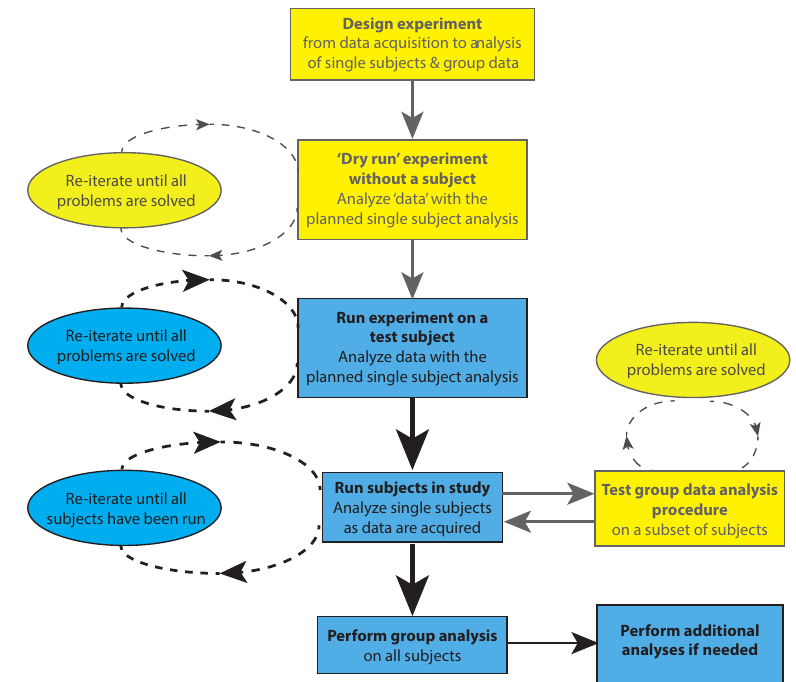
Figure 1. Flowchart for implementing a neurophysiological study. Various stages in planning and testing (yellow boxes) as well as executing (blue boxes) an experimental study are shown. See the text for further